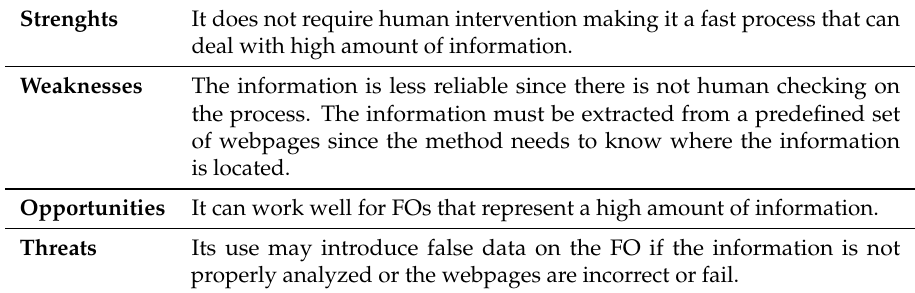
Table 1. SWOT analysis for the automatic approach.